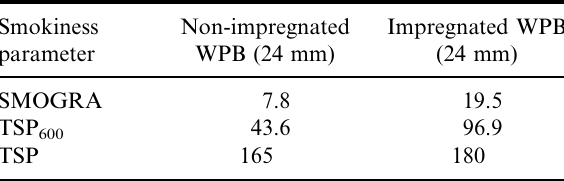
Fig. 6. HRR of impregnated 24 mm WPB. It was noticed that the amount of smoke released from a 24-mm thick WPB is nearly three times greater than that released from a non-impregnated board. It can be explained by the interaction between the fire retardant and a board as well as partial pyrolysis (Table 3) Table 3. Smoke release values of impregnated and non- impregnated